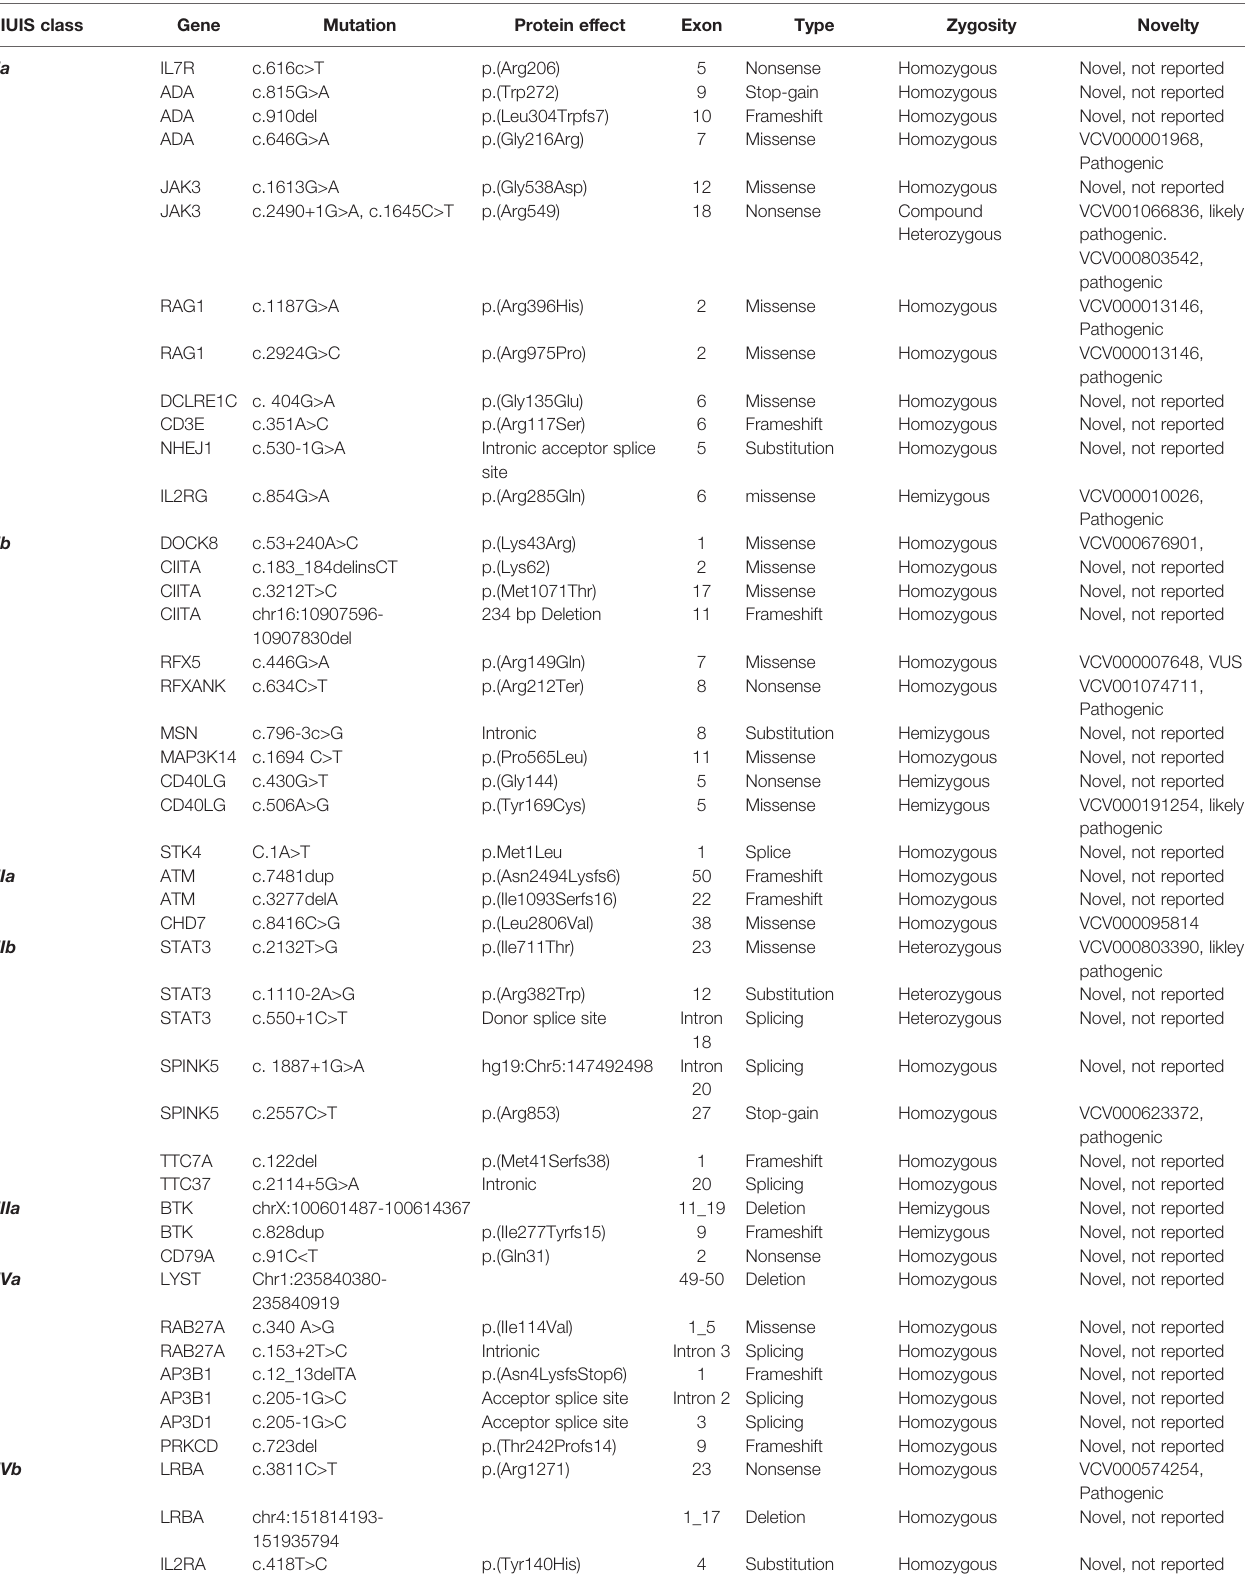
TABLE 4 | Summary of the identi fi ed genotype of IEI cohort shown in categories of IUIS, unclassi fi ed IEI, and potentially disease-causing variants. IUIS